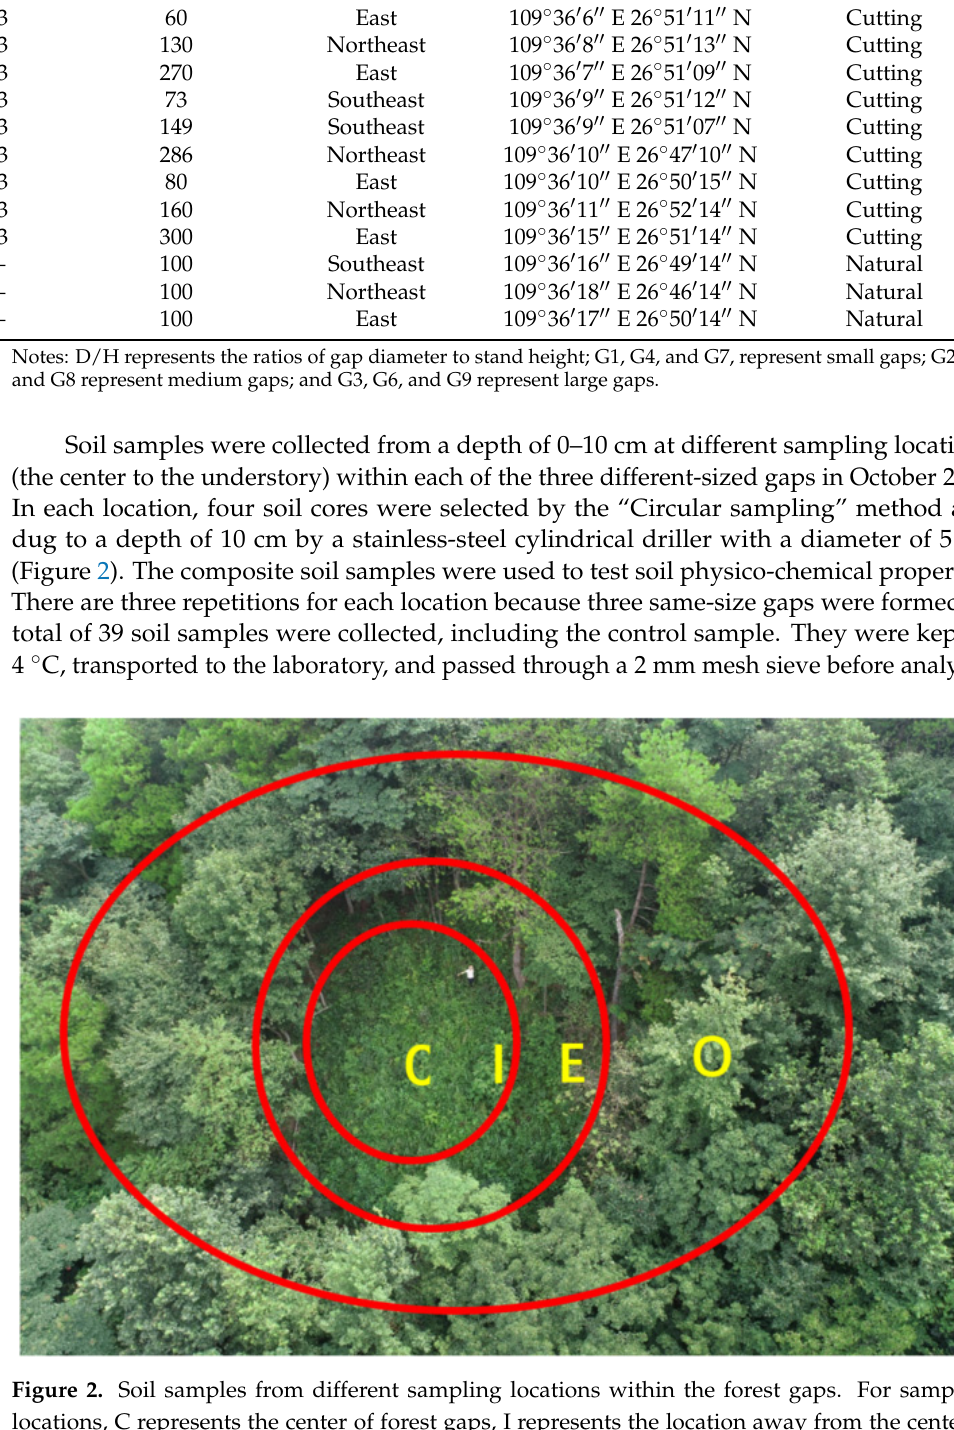
Table 1. General information of the forest gaps and control plots (understory) in this study.